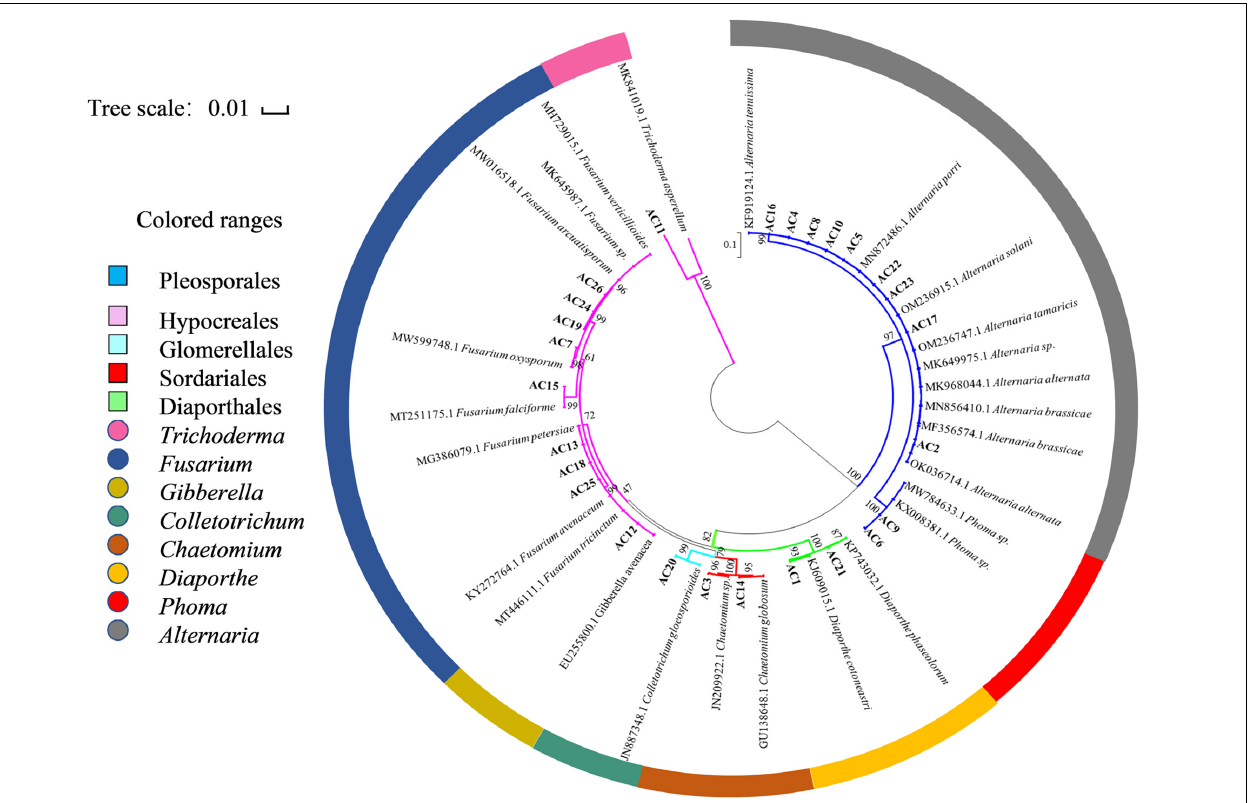
FIGURE 2 | Neighbor-joining phylogenetic tree based on ITS sequences of 26 endophytic strains. Numbers at the branch points are the bootstrap values based on 1,000 resamplings. The scale bar represents 0.01 nucleotide changes per